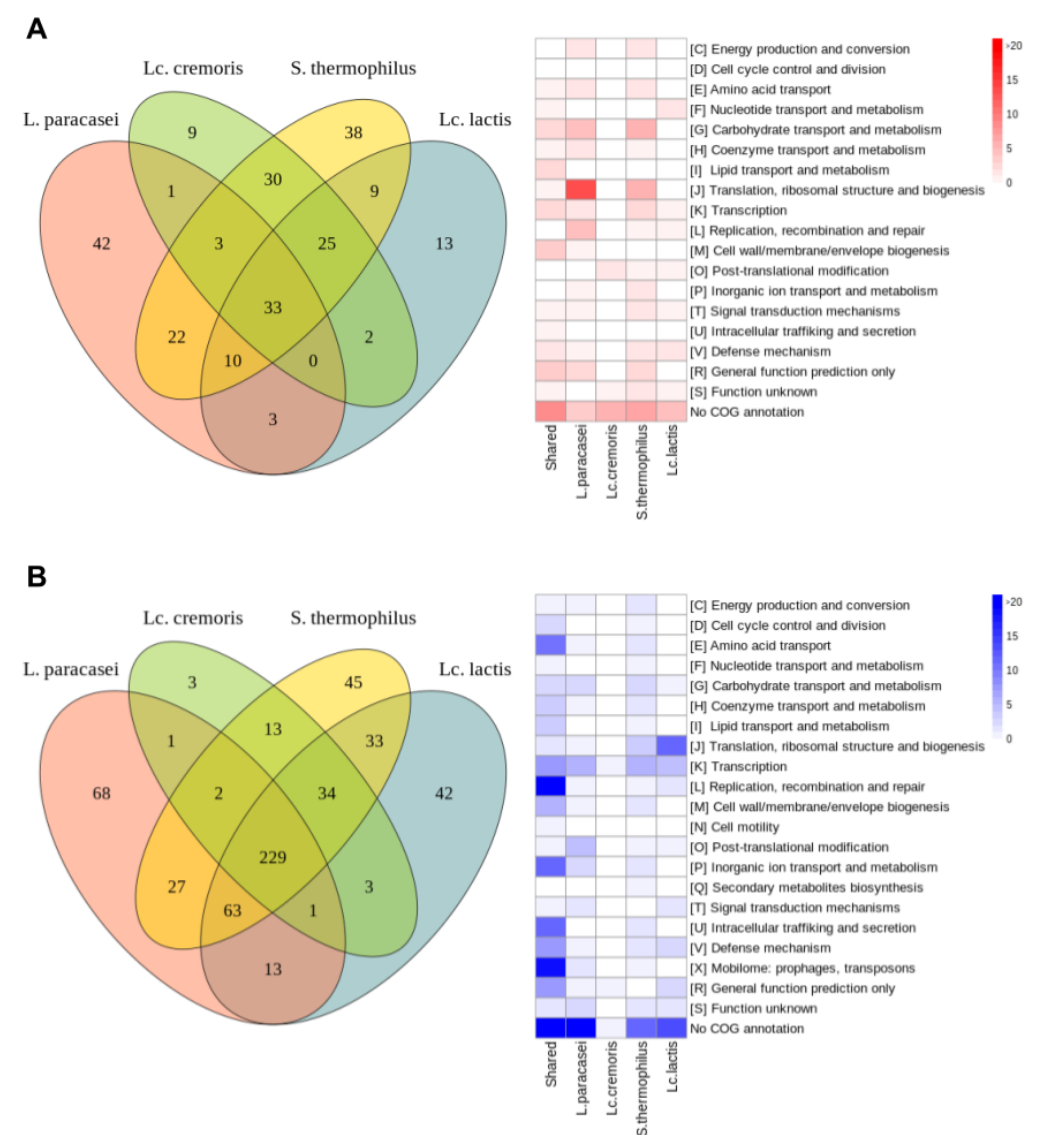
Figure 4. Transcriptional response of F. prausnitzii to cell-free supernatants. Venn diagrams of differentially expressed ( A ) upregulated and ( B ) downregulated genes. Gene functions, based on the COG classification, are shown in a heatmap to the right of the Venn diagrams for the upregulated and downregulated genes. The heatmap colors indicate the number of genes for each category of the COG